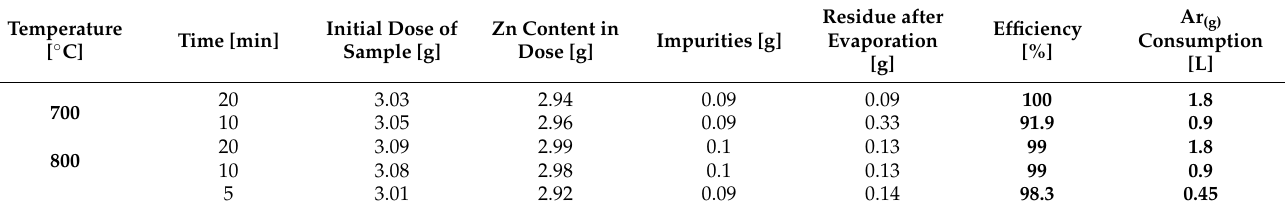
Table 4. Zinc efficiency within temperature and time of evaporation.